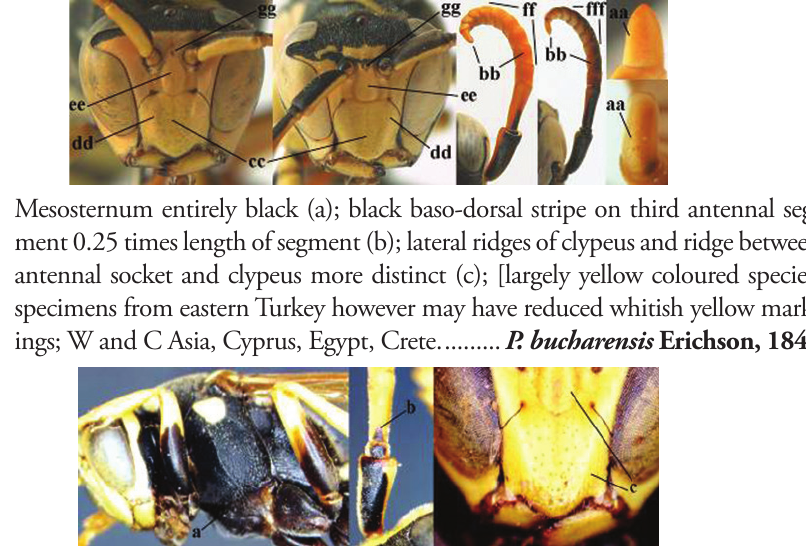
– Mesosternum at least with some yellow spots posteriorly (aa), and often en- tirely yellow, but in some males of P. dominula from southern Greece entirely black; black baso-dorsal stripe on third antennal segment at least 0.5 times length of segment (bb); clypeus laterally nearly flat and ridge between anten- nal socket and clypeus indistinct (cc) ........................................................ 27